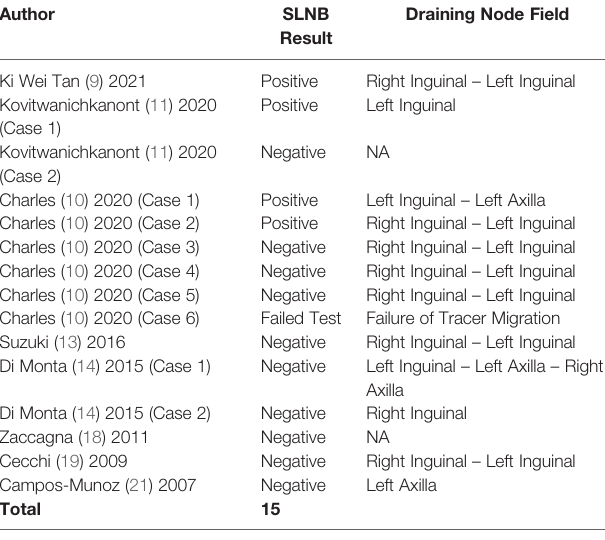
TABLE 2 | Synopsis of Sentinel Node Biopsy